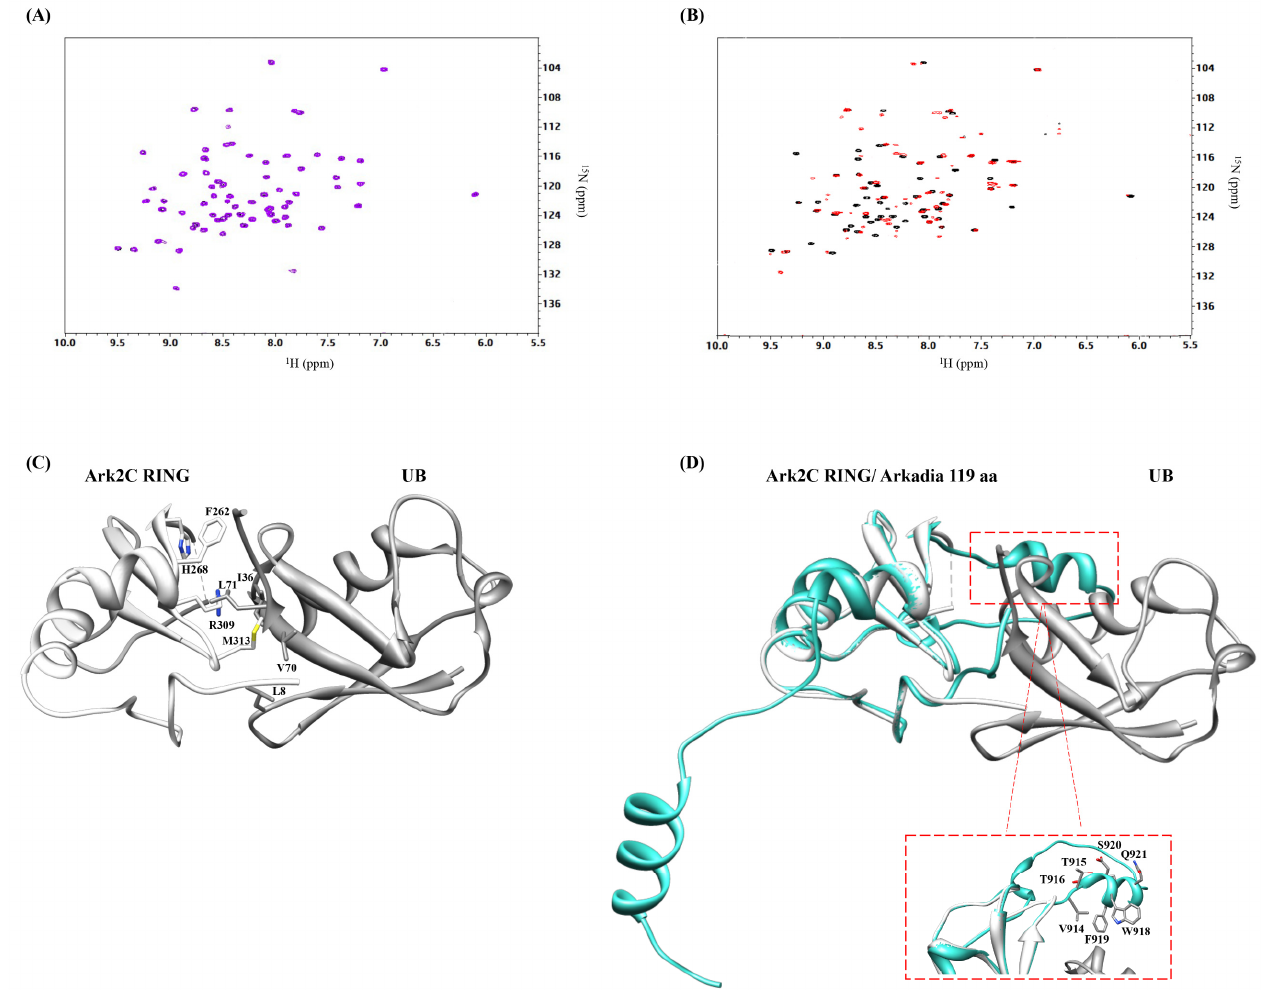
Figure 8. 1 H- 15 N HSQC spectrum of Ub (black) after addition of either ( A ) Arkadia 119 aa isoform 1 (magenta) or ( B ) Arkadia isoform 2 (red). ( C ) Representation of Arkadia 2C (Ark2C)-Ub complex. ( D ) Arkadia 119 aa AlphaFold predicted structure (cyan) matched onto the Ark2C bound protein (white) structure using the MatchMaker tool of UCSF Chimera.